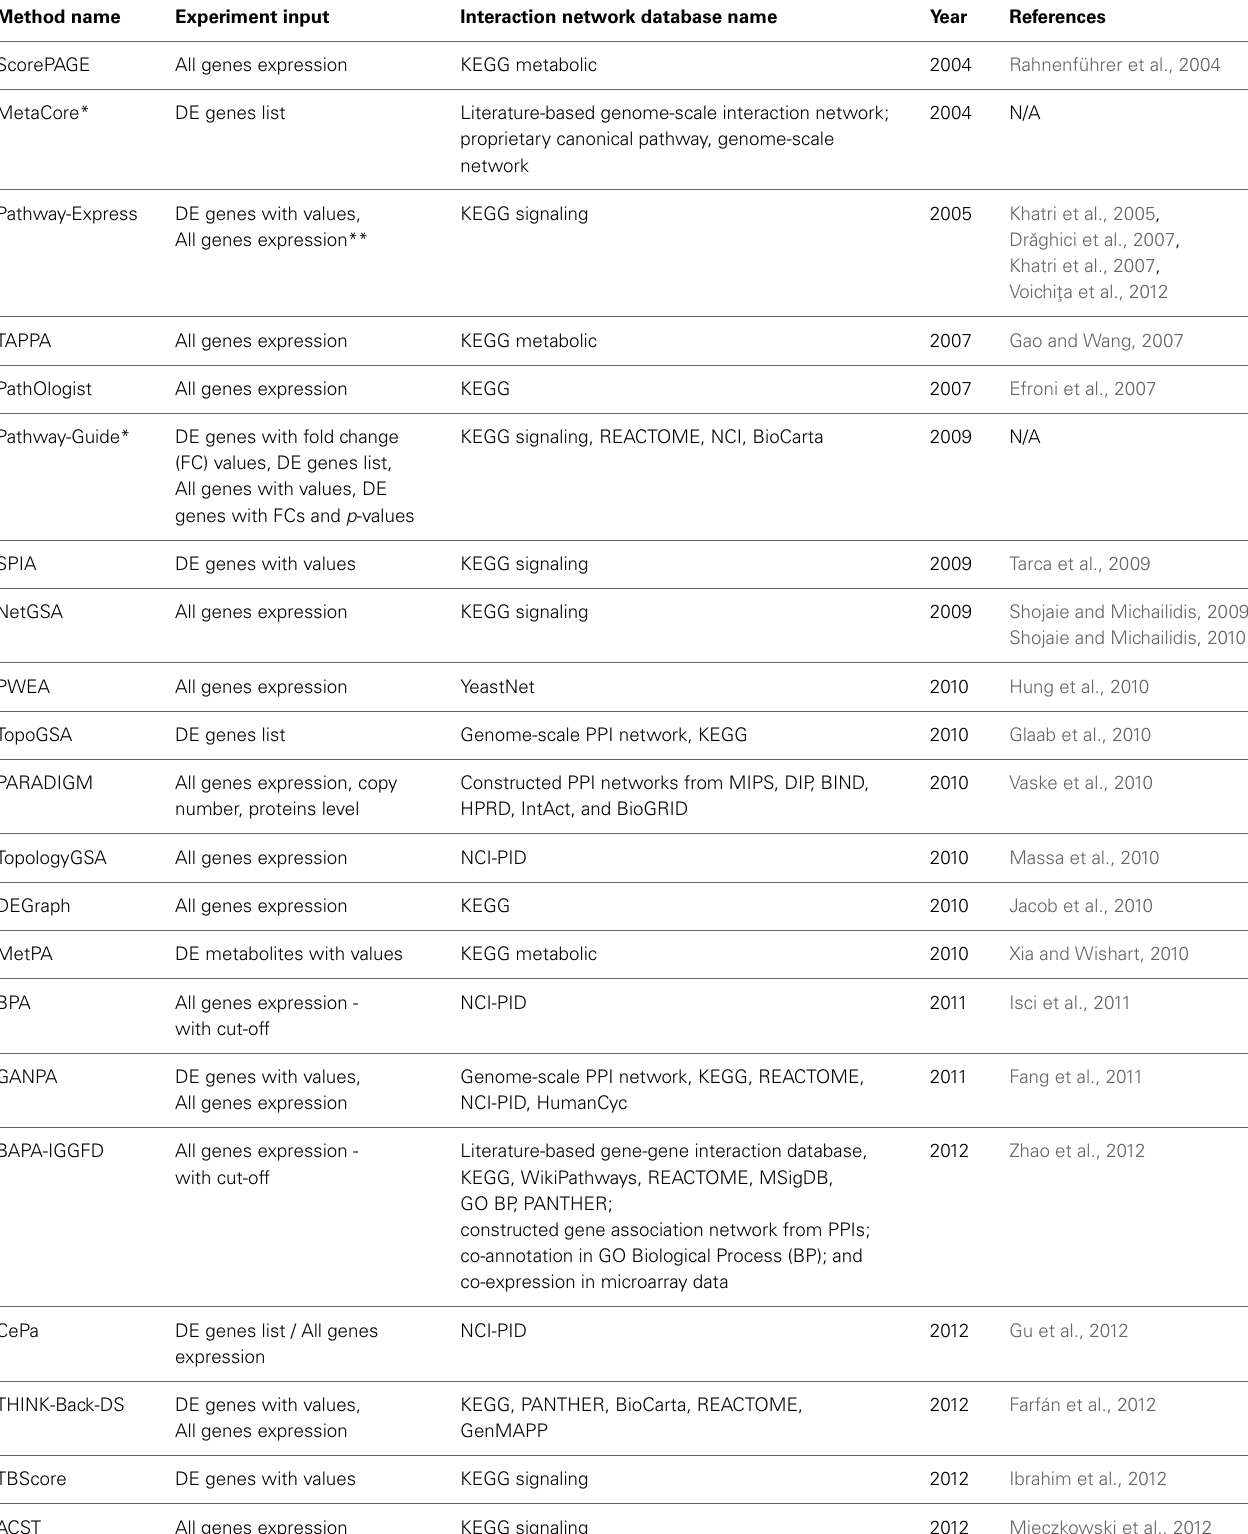
Table 1 | Comparison of topology-based pathway analysis methods based on different criteria related to the